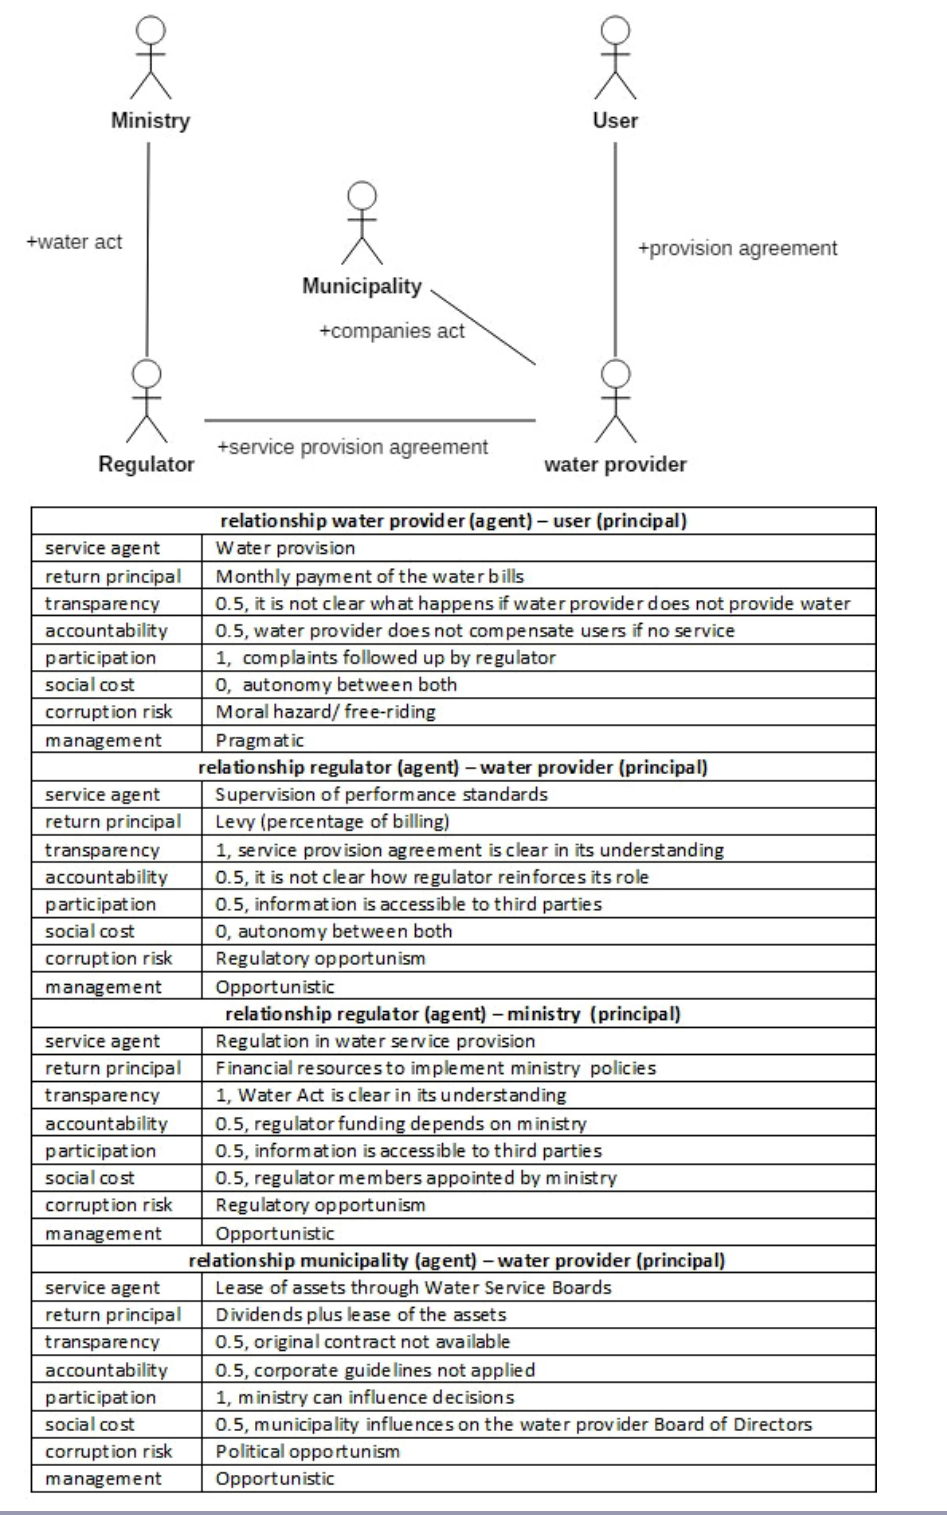
Fig. 1 . Main actors involved in water service delivery (WSD) in